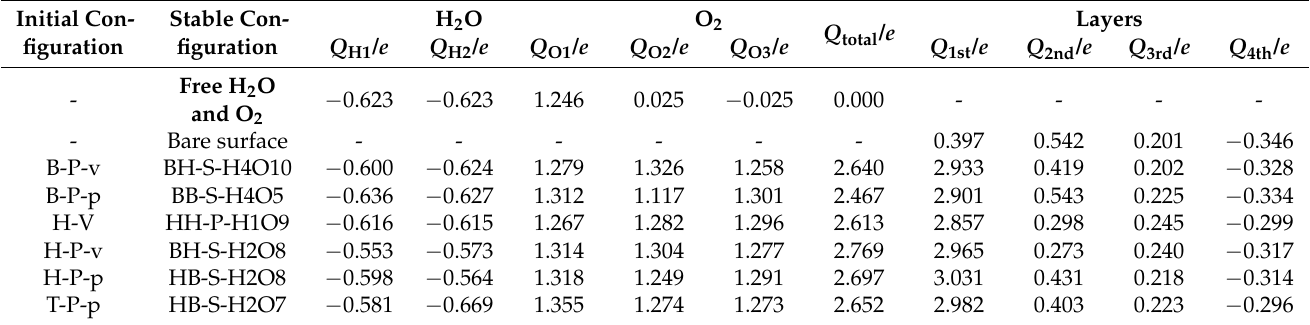
Table 2. Net charge distribution of co-adsorption stable configuration obtained when H 2 O is preferentially adsorbed. Initial Con- Stable figuration